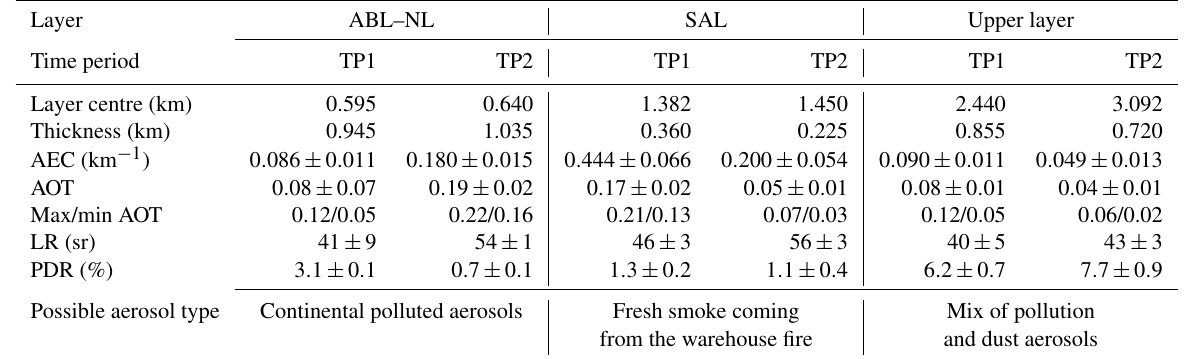
Figure 10. Examples of retrieved profiles of ( a ) aerosol extinction coefficient (AEC), ( b ) lidar ratio (LR), and ( c ) linear particle depolarization ratio (PDR) of 1h lidar measurements centred on 17 April 20:49UTC and 18 April 01:52UTC. Mean values are shown by black lines and grey and green shaded areas indicate the atmospheric variability during this 1h period. Table 2. Average optical properties (at 355nm) for the ABL–NL (atmospheric boundary layer–nocturnal layer), the SAL (smoke aerosol layer), and the upper layer during two time periods (TPs): TP1: 17 April, 20:19–21:35UTC, TP2: 18 April, 02:00–04:00UTC. The atmo- spheric variability during the time period is given by the standard derivation